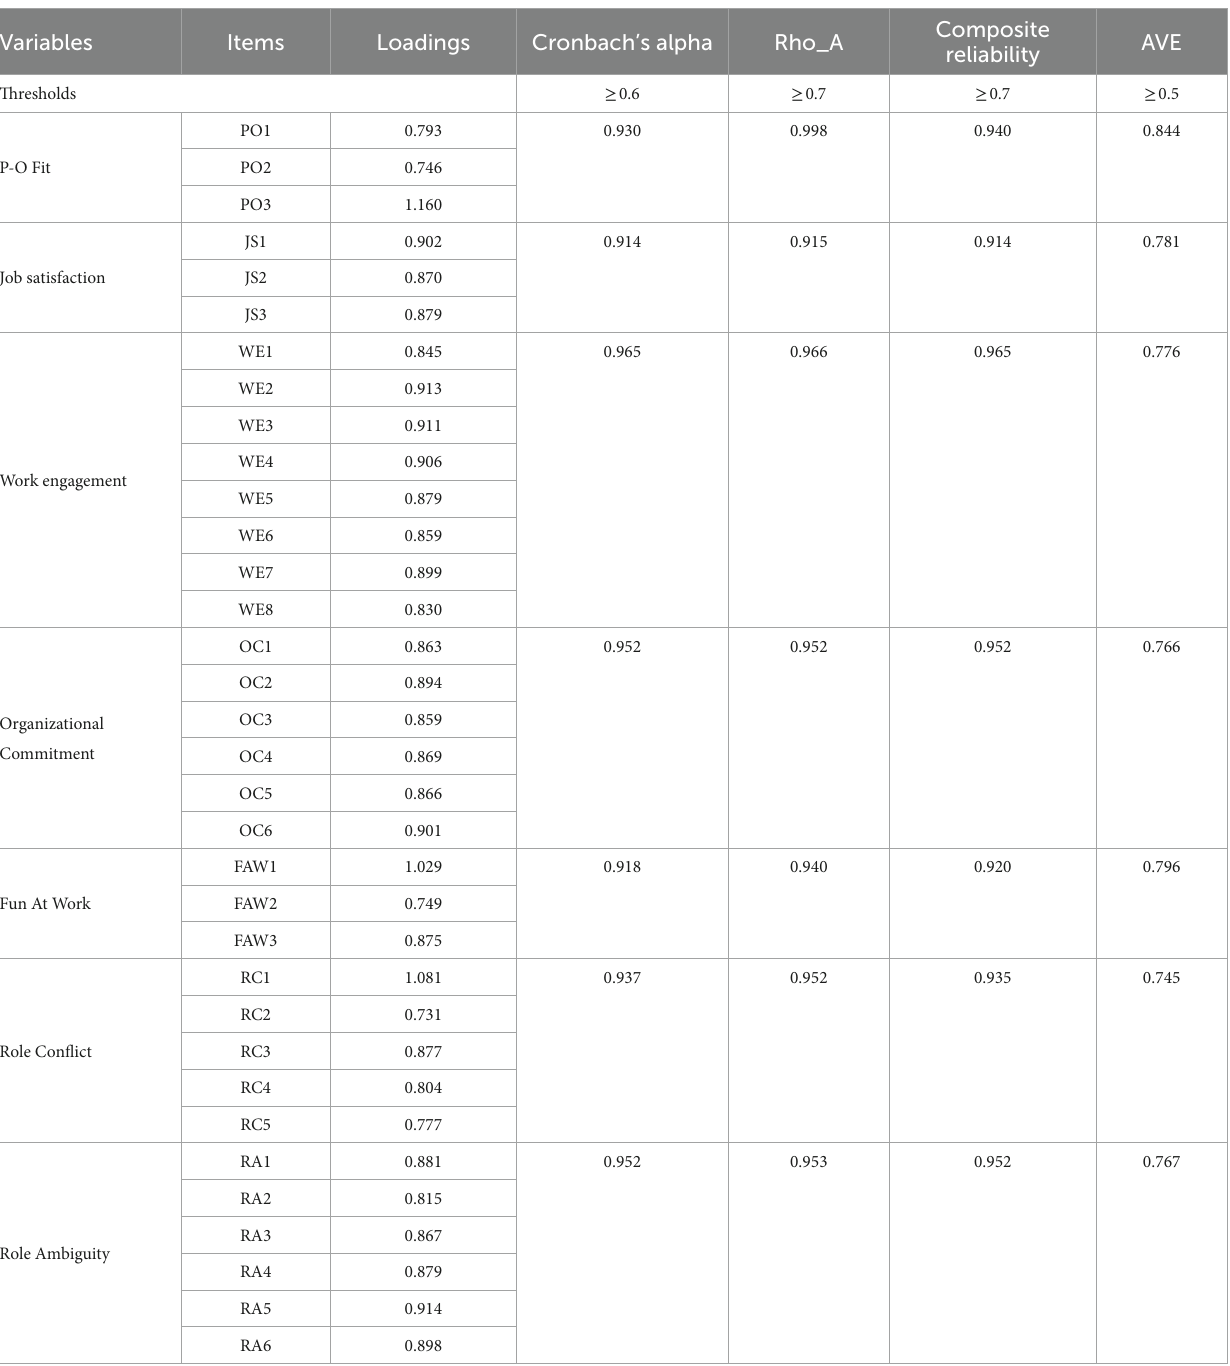
TABLE 2 Model measurement